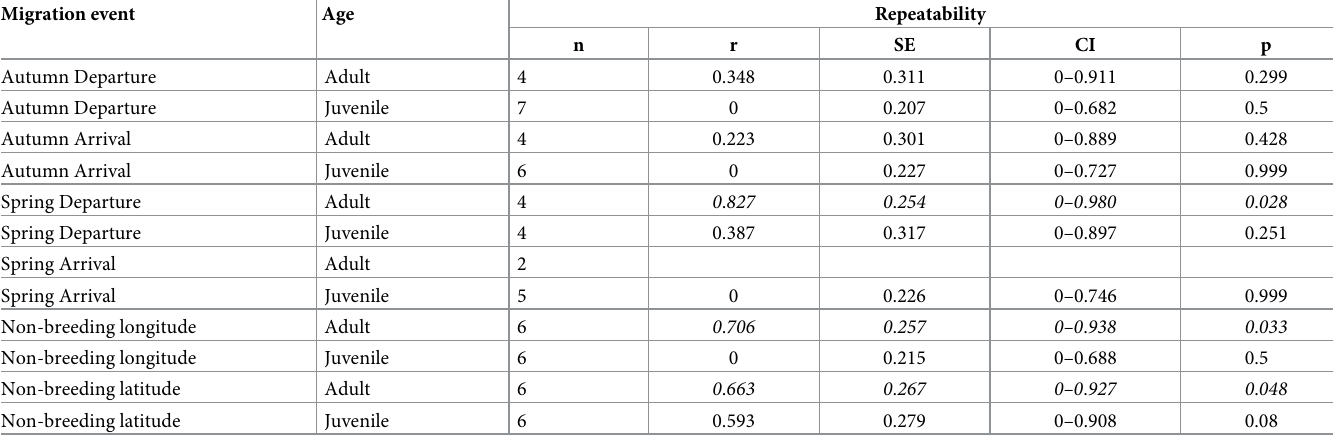
Table 1. Repeatability (r) of migration timing and non-breeding longitude and latitude for juvenile and adult Cyprus wheatears. Sample size is the number of indi- viduals and each individual was measured in two consecutive years. The repeatability score r ranges from 0 to 1 with a score of 1 indicating high similarity between years. The p-value tests if r is significantly different from zero. Italicized numbers are significant.